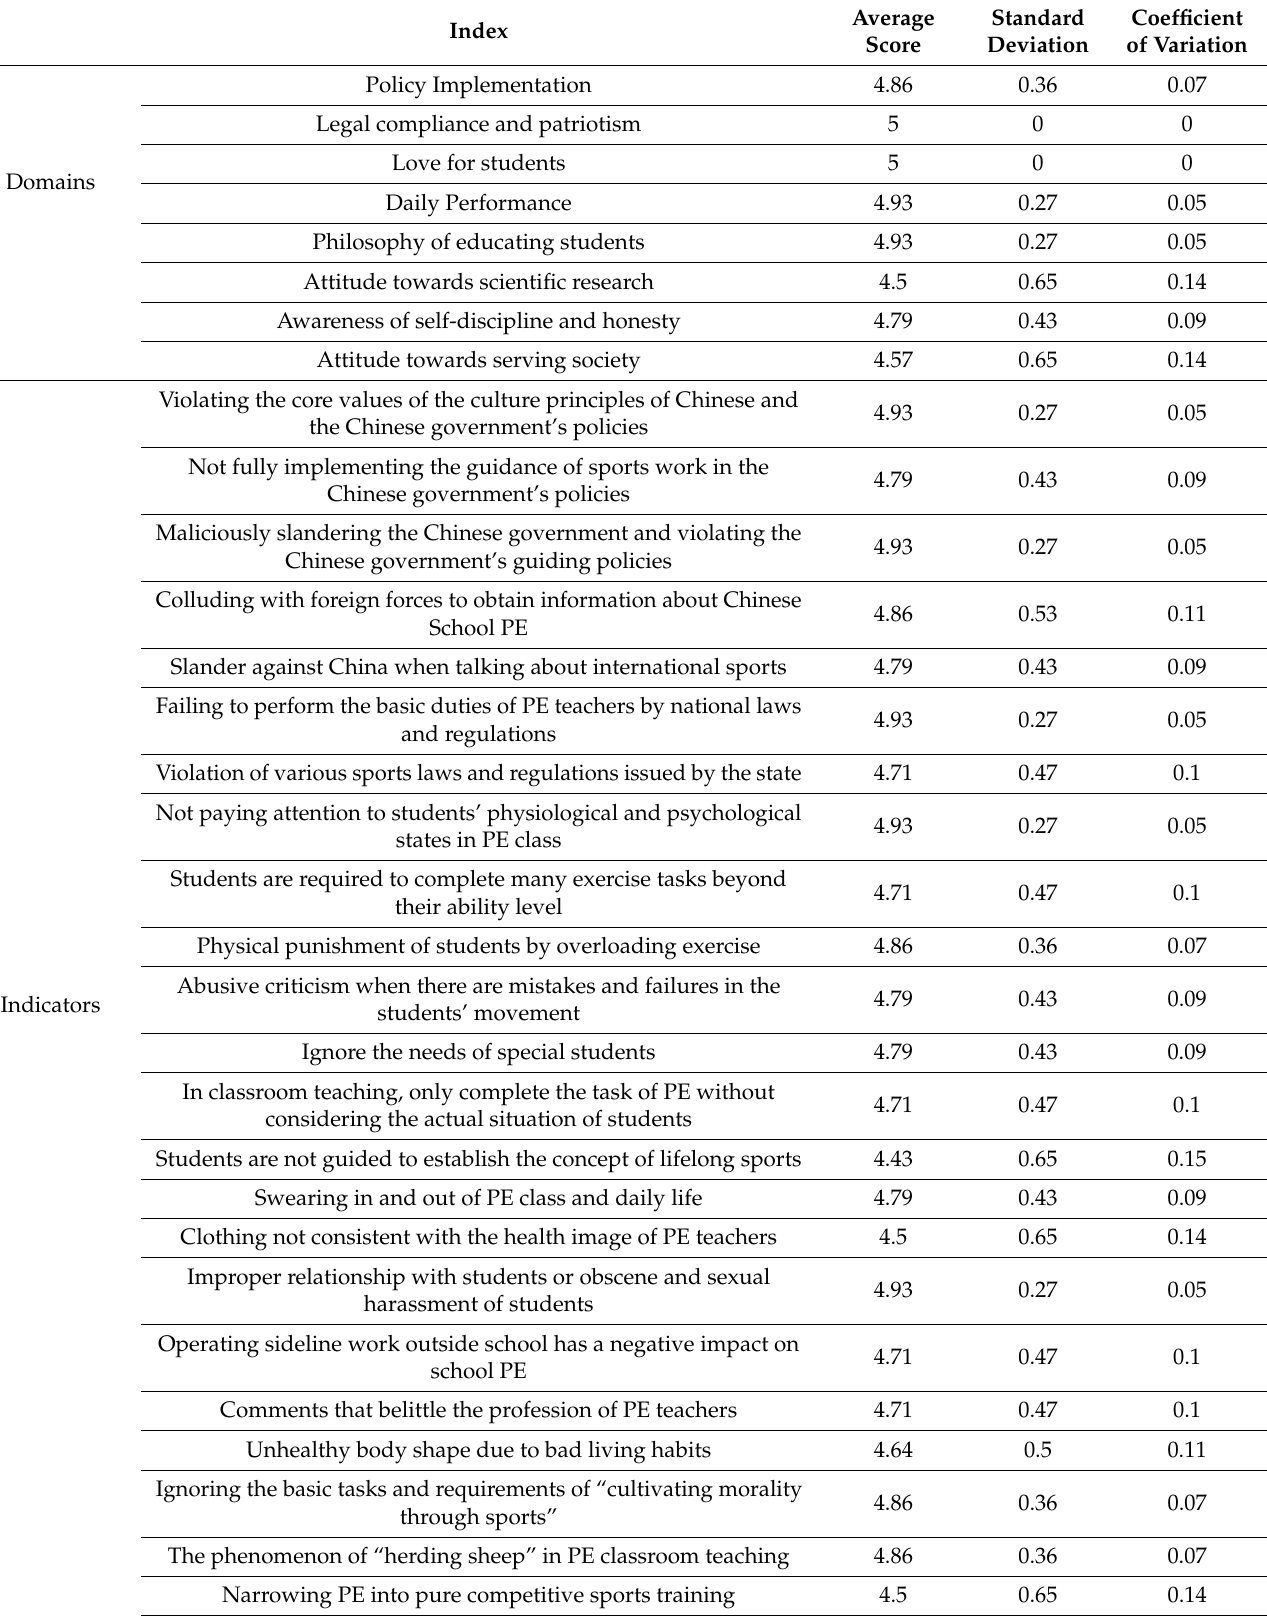
Table A2. The result of Round